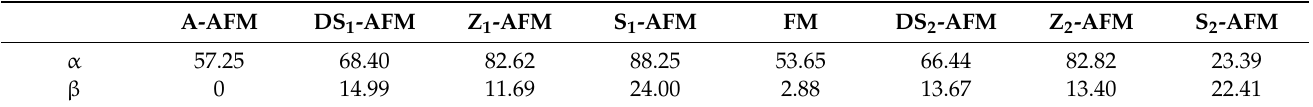
Table 1. The energy differences of four in-plane collinear spin configurations. Interlayer coupling has also been considered, in which the AFM interlayer coupling is denoted by subscript 1 and the FM coupling is represented by subscript 2, respectively. The total energy of the ground state ( β phase with A-AFM order) is taken as the reference value, in units of